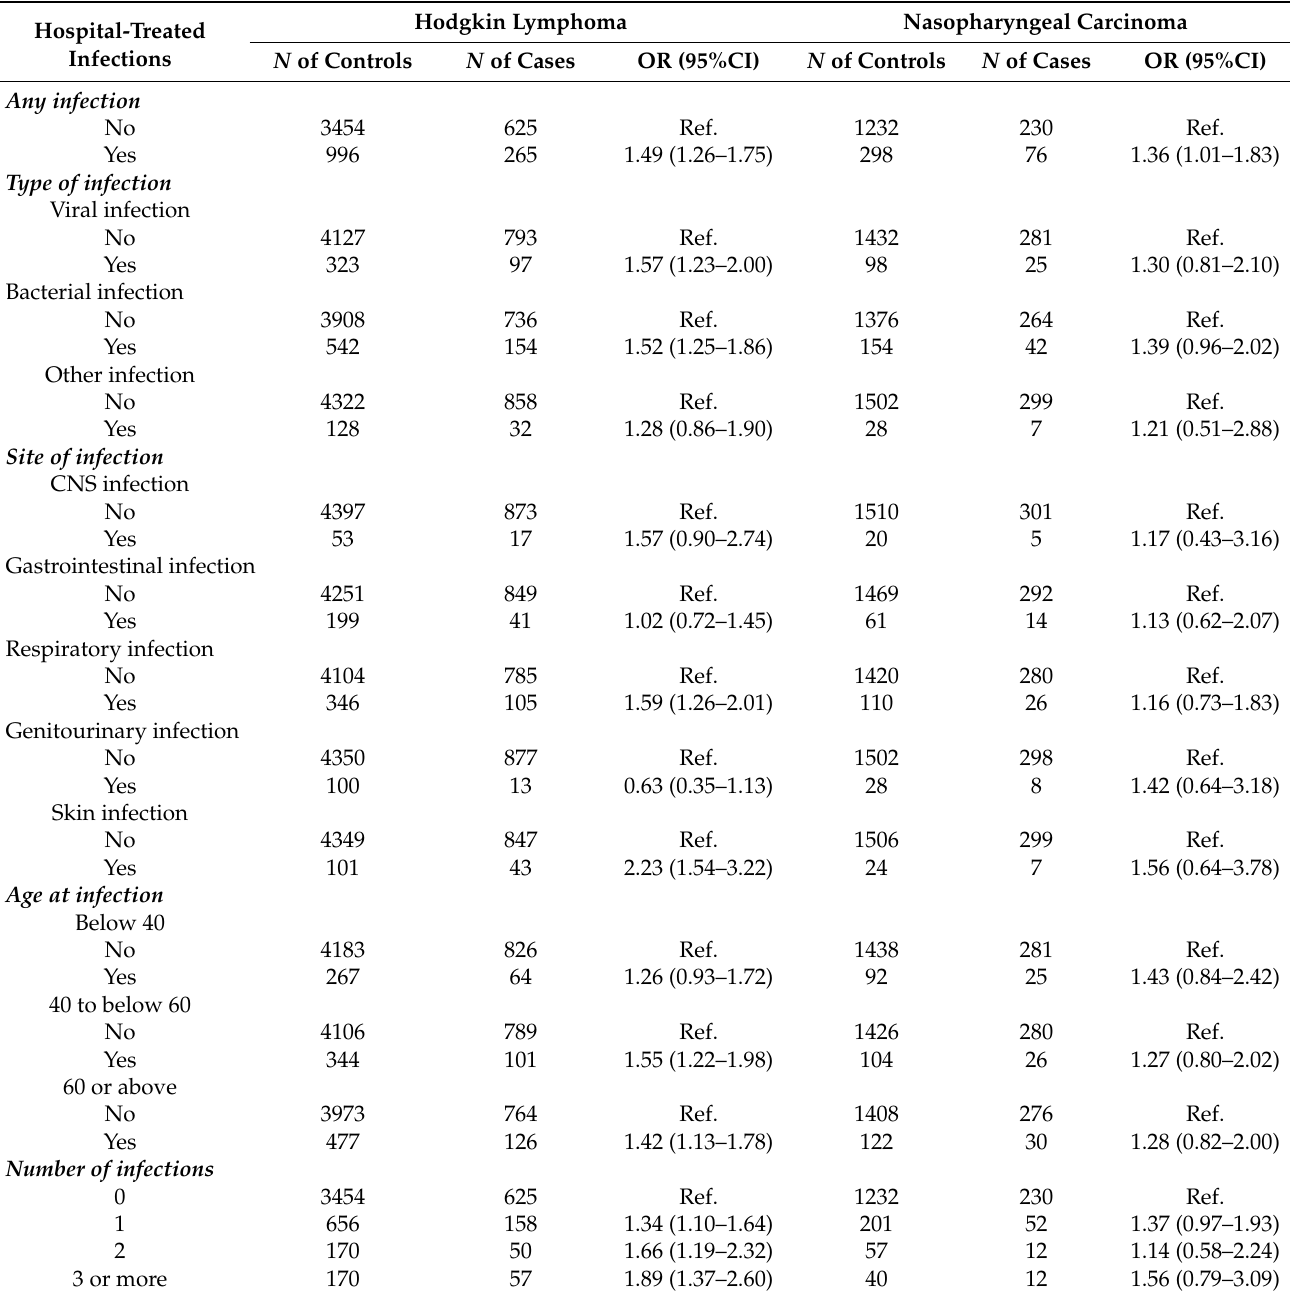
Table 2. Odds ratios (ORs) and 95% confidence intervals (CIs) of EBV-related malignancies in relation to hospital-treated infections >3 years before malignancy